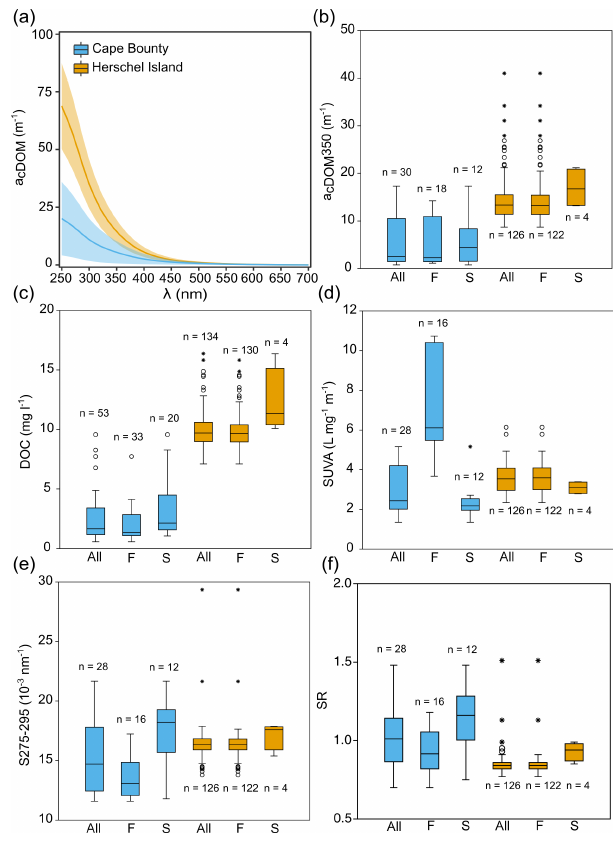
Figure 2. Dissolved organic matter (DOM) quality and quantity for the sites from Herschel Island (HE, in orange) and Cape Bounty (CB, in blue). (a) Average cDOM absorption (m − 1 ) for the wave- lengths ( λ ) between 250 and 700nm. The coloured shaded ar- eas represent the standard deviation from the mean (solid line). Boxplots of (b) coloured dissolved organic matter (cDOM) ab- sorption at 350nm a cDOM 350 (m − 1 ), (c) dissolved organic car- bon, DOC (mgL − 1 ), (d) specific ultraviolet absorbance, SUVA (Lmg − 1 m − 1 ), (e) cDOM slope S275–295 (10 − 3 nm − 1 ), and slope ratio SR. The plots depict distributions for all samples (all) and sub- sets of flowing water (F) and standing water (S) for each of the